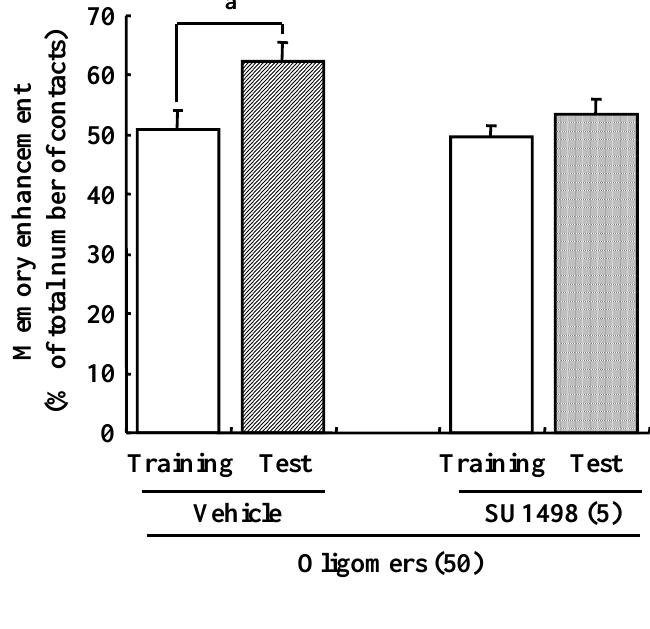
Figure 12. Effects of oligomers and VEGFR-2 on memory. Male ddY mice (6 weeks old) were administered oligomers (O (50), 50 mg/kg body weight/day, p.o., n = 4) for 7 days. Then, the vehicle (Veh, 5% DMSO in 0.9% NaCl) was injected intracerebroventricularly at 60 min after the final administration of oligomers. Five days after vehicle injection, SU1498 (5 nmol/μL, solution is 5% DMSO in 0.9% NaCl) was injected intracerebroventricularly at 60 min after the final administration of oligomers. a p = 0.0392 (Student’s t